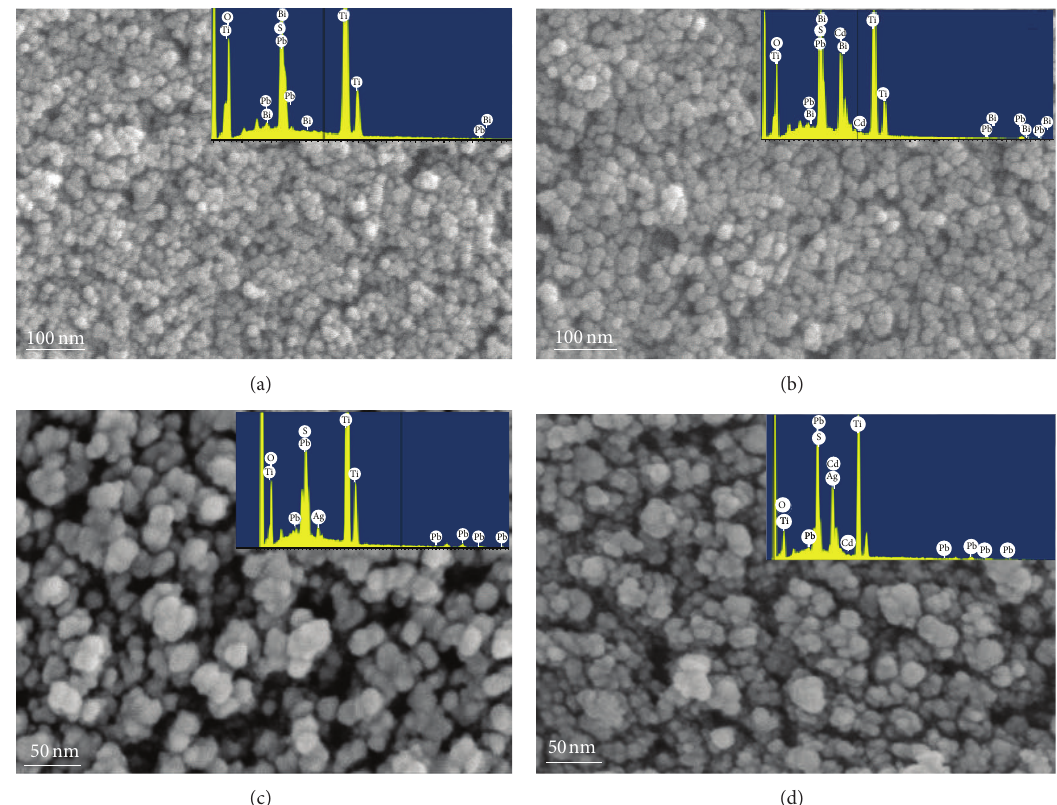
Figure 1: SEM images of TiO 2 /Bi-doped-PbS, TiO 2 /Bi-doped-PbS/CdS, TiO 2 /Ag-doped-PbS, and TiO 2 /Ag-doped-PbS/CdS. Insets in images are corresponding EDS spectra.